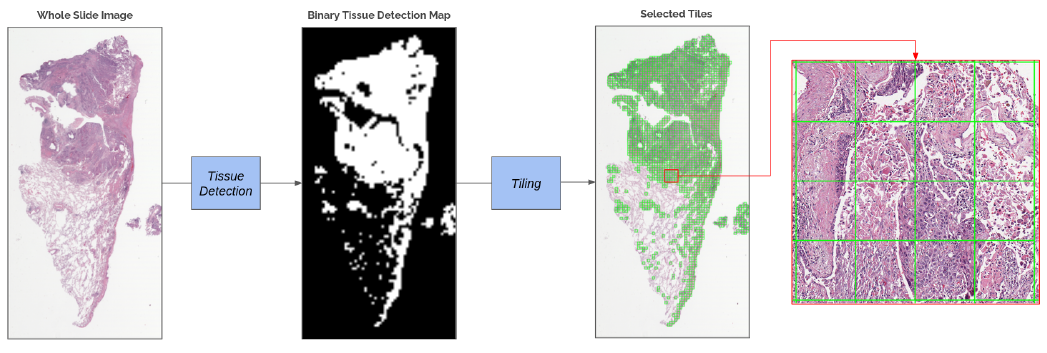
Figure 1. Illustration of tissue detection and tiling